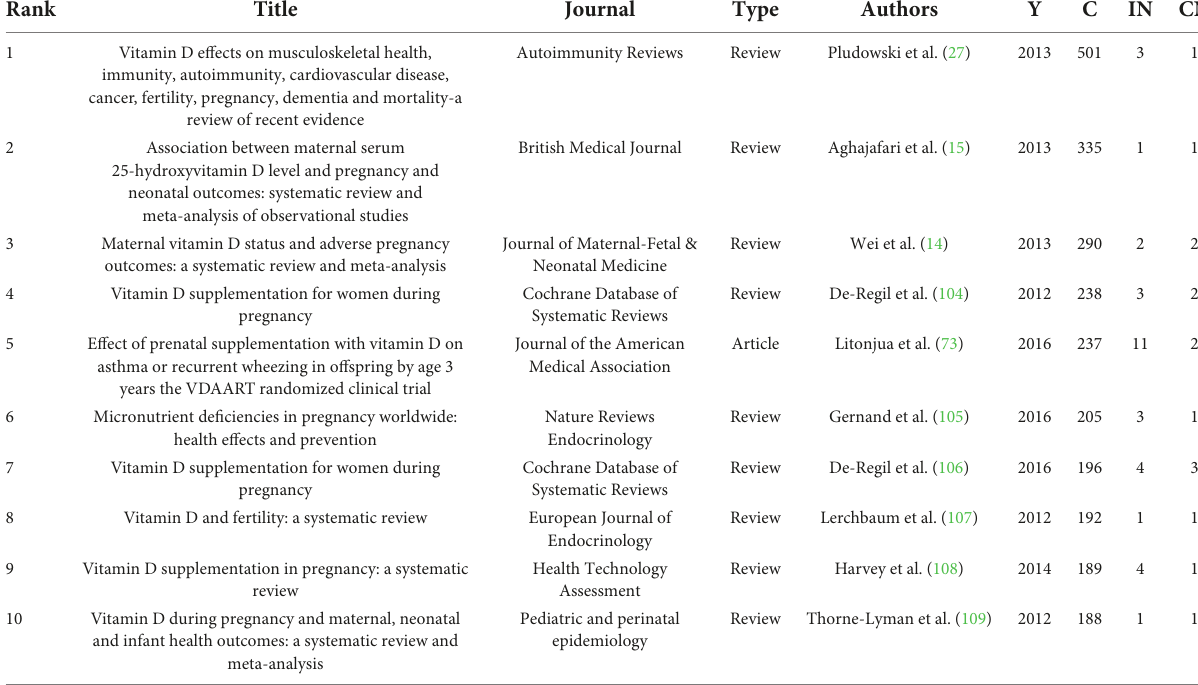
TABLE 6 Top 10 citation analysis of documents on vitamin D and reproductive